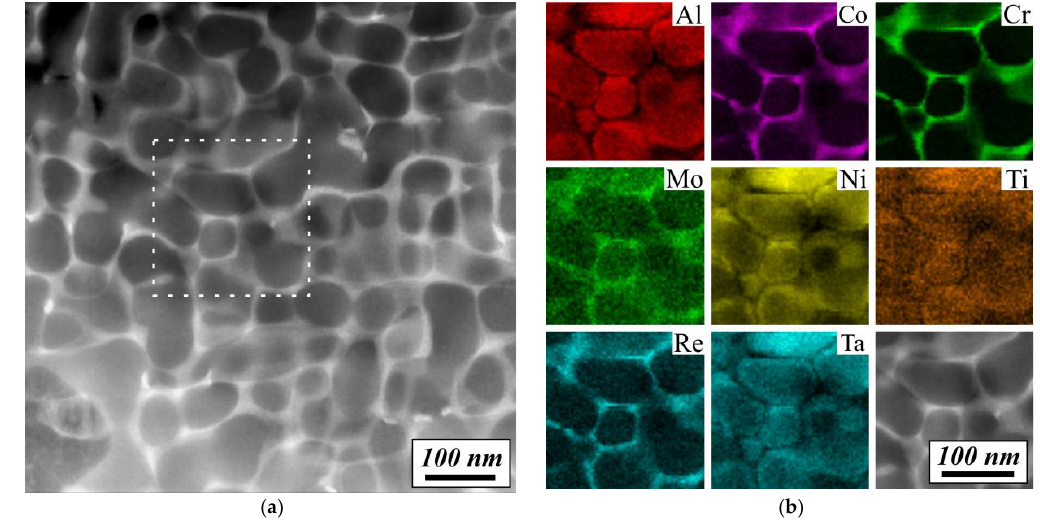
Figure 12. Distribution of alloy elements in the SEBM microstructure of Specimen A. ( a ) STEM-HAADF image of the γ/γ′ microstructure (200 nm scale); multiple beam condition, beam close to [001] crystallographic direction. ( b ) Corresponding element distribution maps, color coded as indicated.